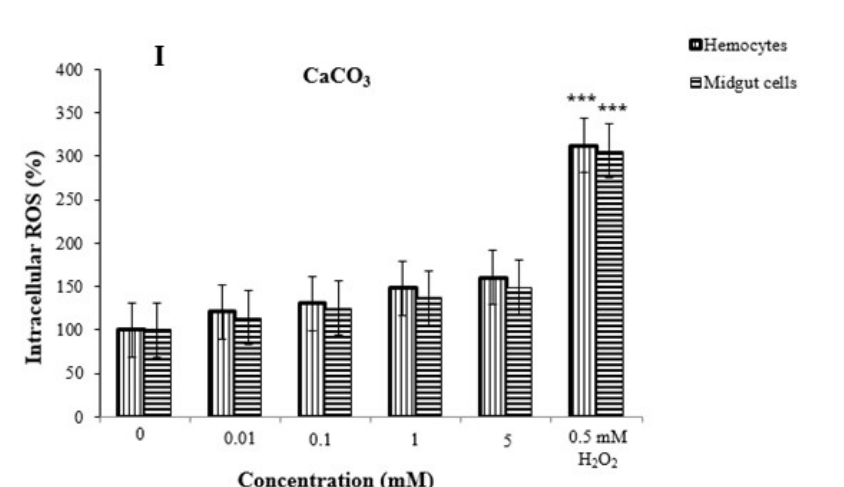
Figure 9. ROS production in hemocytes and midgut cells of third-instar untreated (0) and treated larvae exposed to different concentrations of permethrin ( A ), permethrin nanopesticides ( B ), CuSO 4 · 5H 2 O ( C ), Cu(OH) 2 nanopesticides ( D ), acephate ( E ), acephate nanopesticides ( F ), validamycin ( G ), validamycin nanopesticides ( H ), and CaCO 3 ( I ). Hemocytes and midgut cells were incubated with 5 µM DCFH-DA at 24 °C for 30 min and observed via fluorescence microscopy. The fluorescence intensity of the hemocytes and midgut cells of larvae treated with permethrin were quantified by ImageJ analysis; 0.5 mM H 2 O 2 was used as a positive control; *** p ≤ 0.001 when compared to the negative control using the Mann–Whitney U -test.